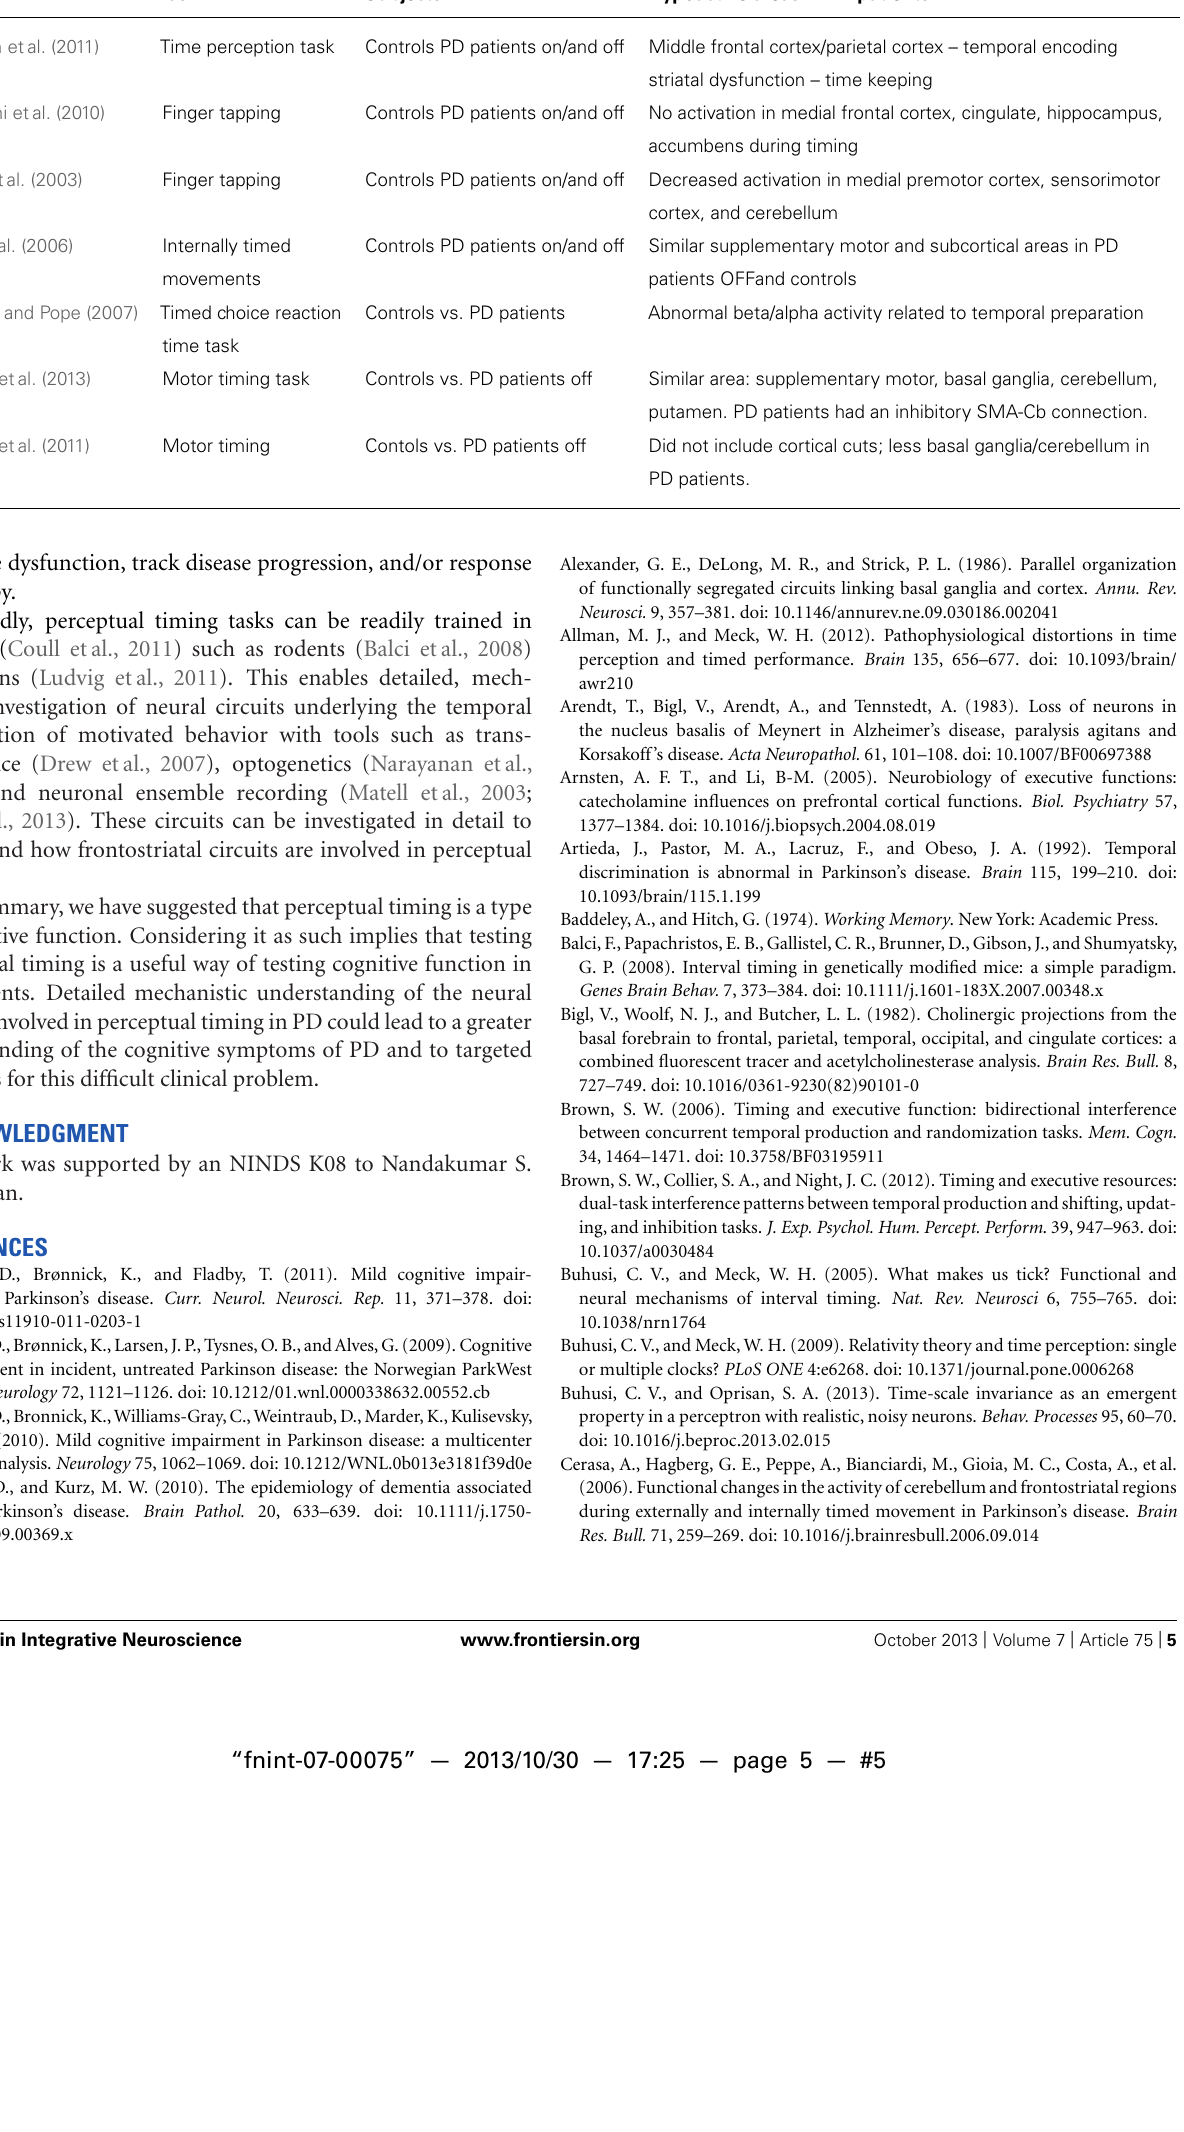
Table 1 | Studies that examine the neuroanatomical basis of timing deficits and PD. Study Harrington etal. (2011)